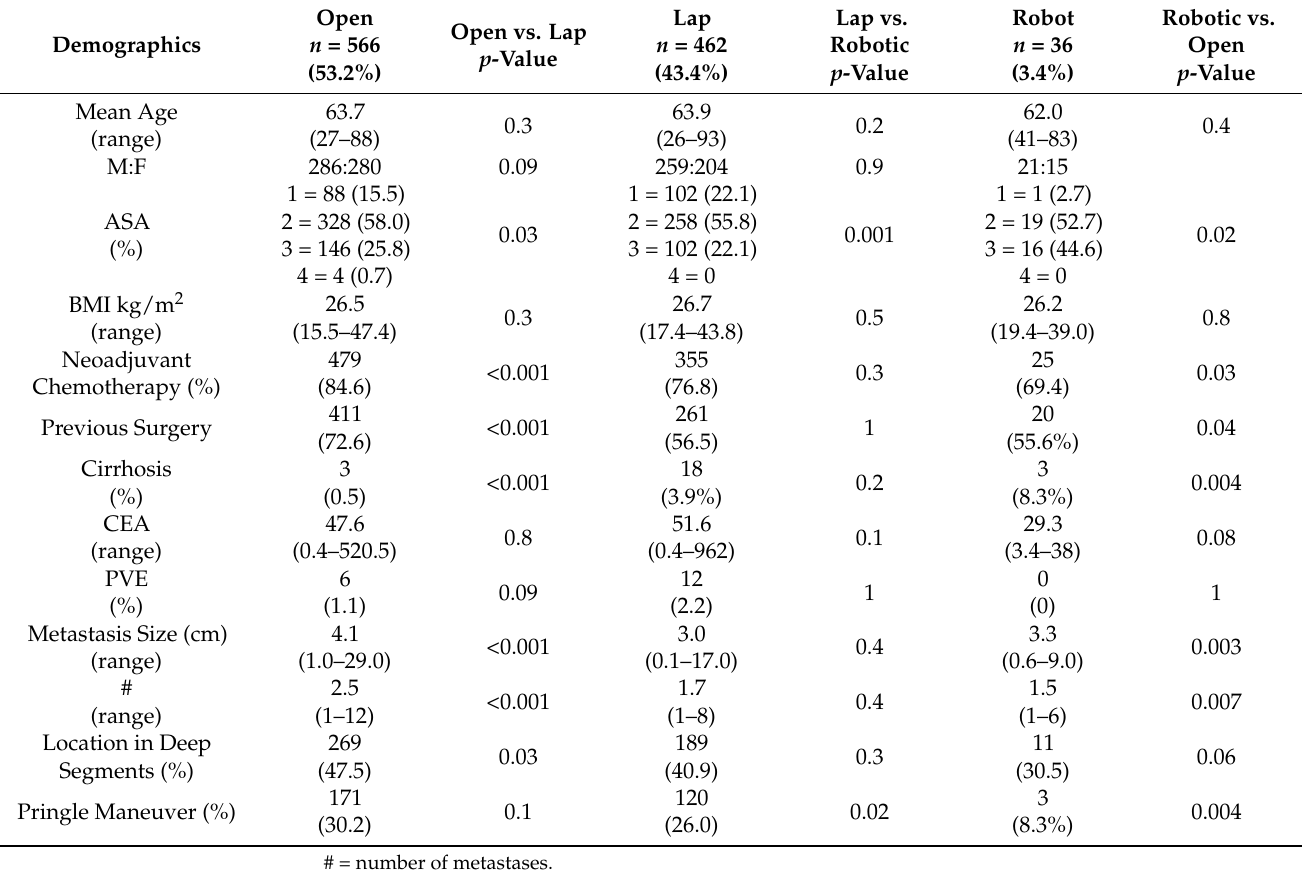
Table 1. Demographics/confounding variables of patients receiving open (OLR), laparoscopic liver resection (LLR) or robotic liver resection (RLR) for colorectal liver metastasis before propensity score matching and before the exclusion criteria were applied (#=number of metastases).